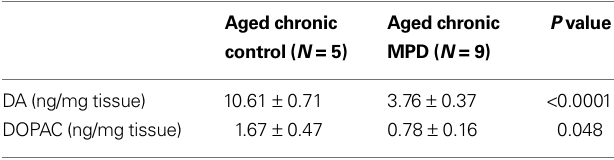
Table 3 | Striatal DA, DOPAC levels in chronic aged (6–10 months old) MPD a